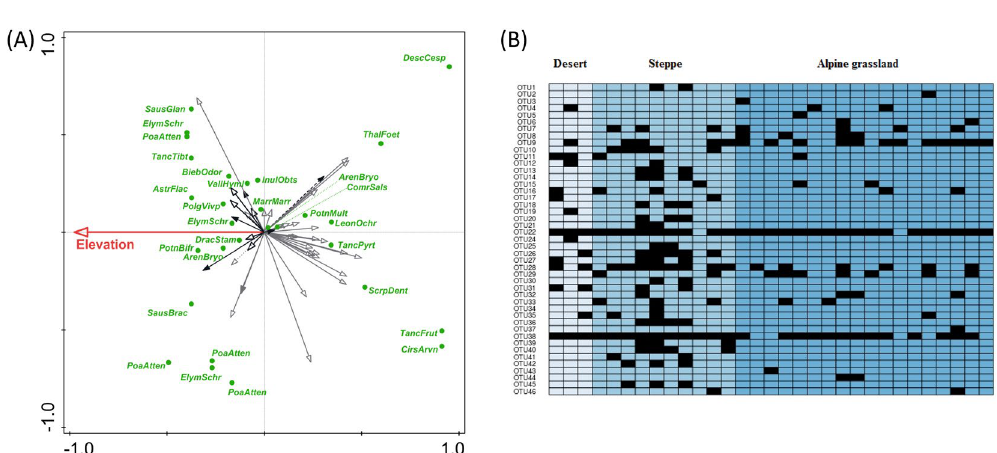
Figure 5. Analysis of AMF community patterns. ( A ) Ordination diagram with the first two partial RDA axes (axes explain 9.2% of the variance left after accounting for phylogenetic relations) showing the relationship between OTU composition and elevation. Small arrows point in the direction of increasing expected values of OTUs occurrence, the large arrow points in the direction of increasing expected value of elevation. The twenty best-fitted plant species are shown. AMF families are indicated by arrow type: Glomeraceae (empty grey arrows), Gigasporaceae (filled grey arrow), Acaulosporacea (filled black arrow with dashed line), Claroideoglomeraceae (empty black arrows), Pacisporaceae (empty grey arrow with dotted line), Diversisporaceae (filled black arrows). For plant taxa, the first four letters from genus and species names are used in diagram, full names are in Table S1. ( B ) Presence-absence heat map showing the occurrence of individual OTUs in different